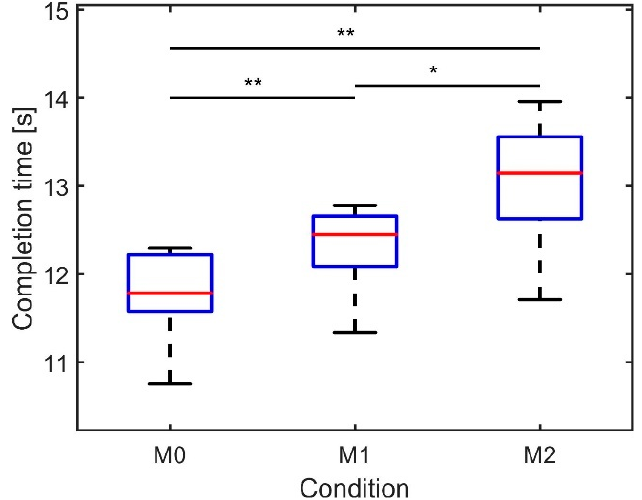
Figure 5. Boxplot of median completion time (s) of the agility run over three repetitions per condition ( n = 10). The asterisks indicate significant differences between the conditions: * p < 0.01, ** p < 0.001.